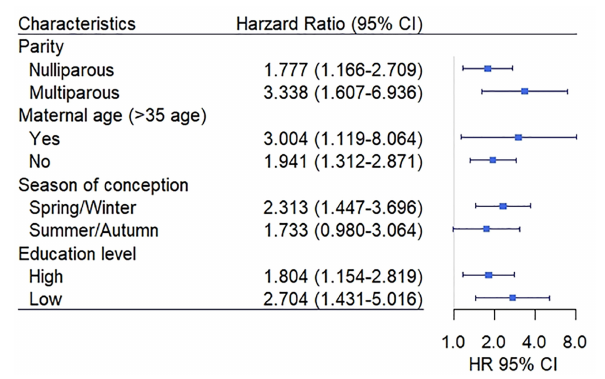
FIGURE 3 | The association between an early GWG category (EwtGCat) and HDP under different subgroup. The Class 1 and Class 2 were defined as low EwtGCat, and Class 3 and Class 4 were grouped into high EwtGCat. The low education level represents high school or below and the high education level includes vocational college and university or